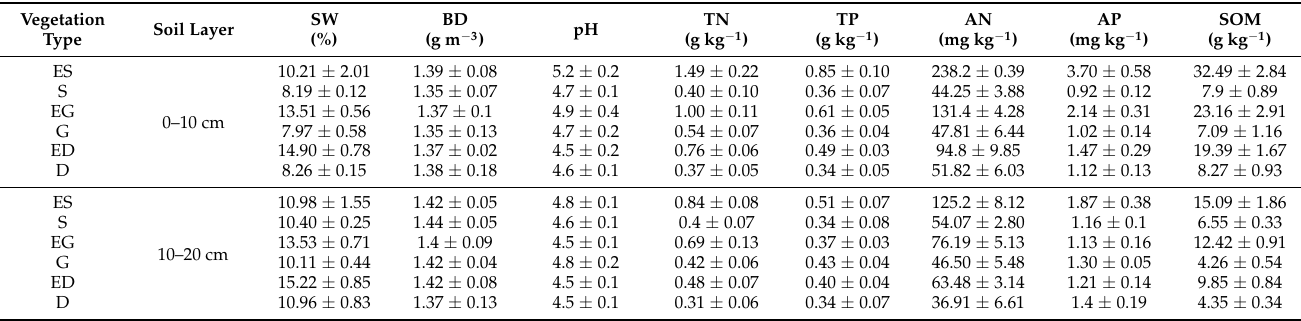
Table 2. Soil physicochemical properties in vegetation restoration with Eucalyptus and natural vegetation restoration without